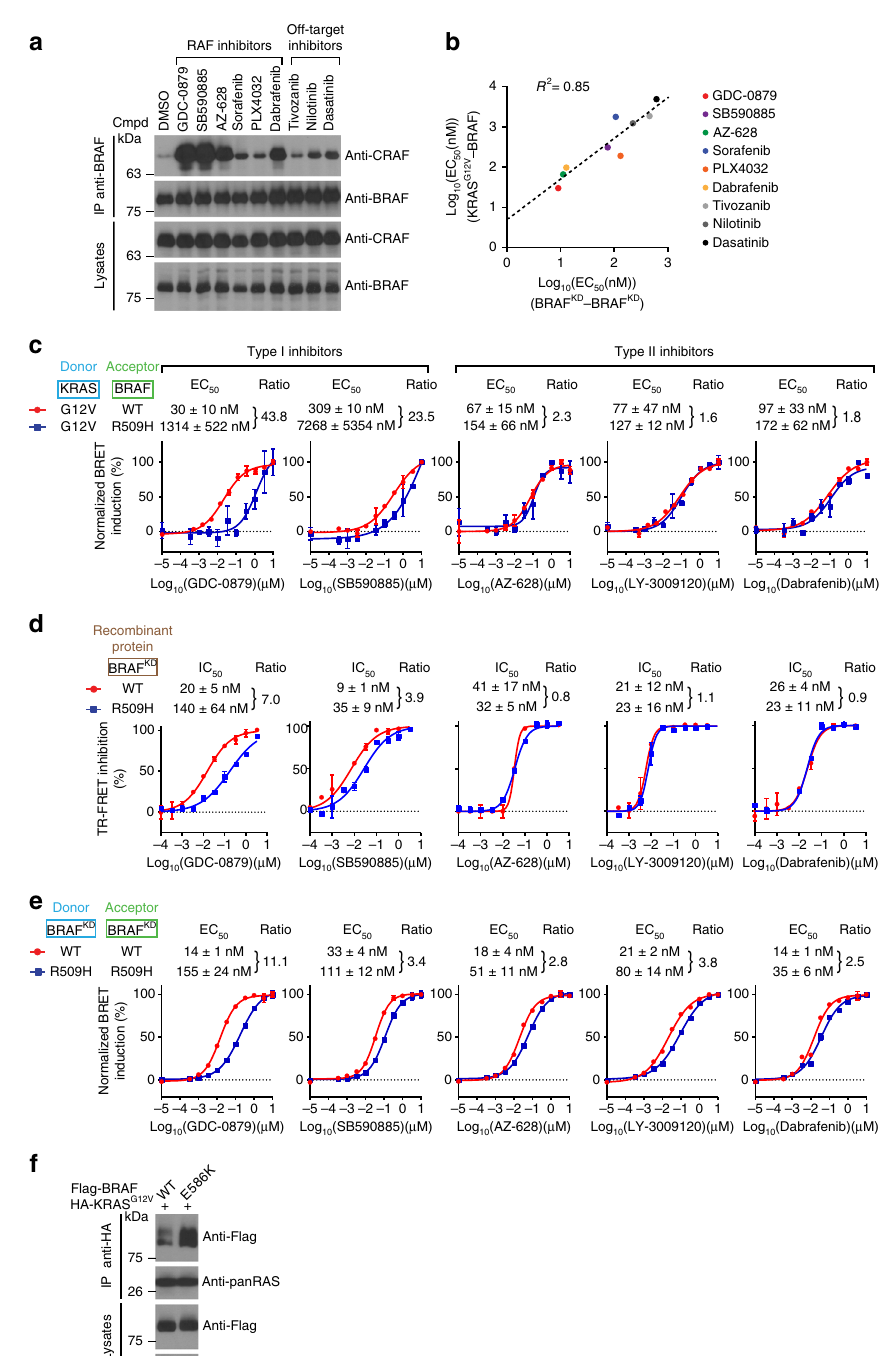
Fig. 2 Inhibitor-induced RAS − RAF association correlates with RAF dimerization. a RAF inhibitors strongly induce the dimerization of endogenous BRAF and CRAF in HEK293T cells as determined by co-IP. Cells were treated with 10 µ M of the indicated compounds. b Correlation between BRAF kinase domain dimerization and KRAS − BRAF association. EC 50 s obtained for each inhibitor in the BRAF − BRAF kinase domain dimerization assay were plotted against the EC 50 s obtained in the KRAS G12V − BRAF BRET assay (Supplementary Fig. 3a, b). c The dimerization-impaired BRAF R509H mutant strongly impedes KRAS G12V − BRAF association induced by type I inhibitors, but weakly affects induction by type II inhibitors. d Binding IC 50 s of representative type I and type II inhibitors determined by TR − FRET using recombinant WT BRAF or BRAF R509H kinase domain. e The R509H substitution alters type I and type II inhibitor-induced BRAF kinase domain dimerization to different degrees. f The dimerization-enhancing BRAF E586K mutant increases basal KRAS G12V − BRAF association. To facilitate comparison between conditions, the range between minimal and maximal BRET signals was normalized to 100% in c , e . Error bars in dose-response curves correspond to mean values ± s.d. of technical duplicates of a representative biological triplicate. EC 50 s and IC 50 s are the average of at least three independent repeats (Supplementary Data 1)